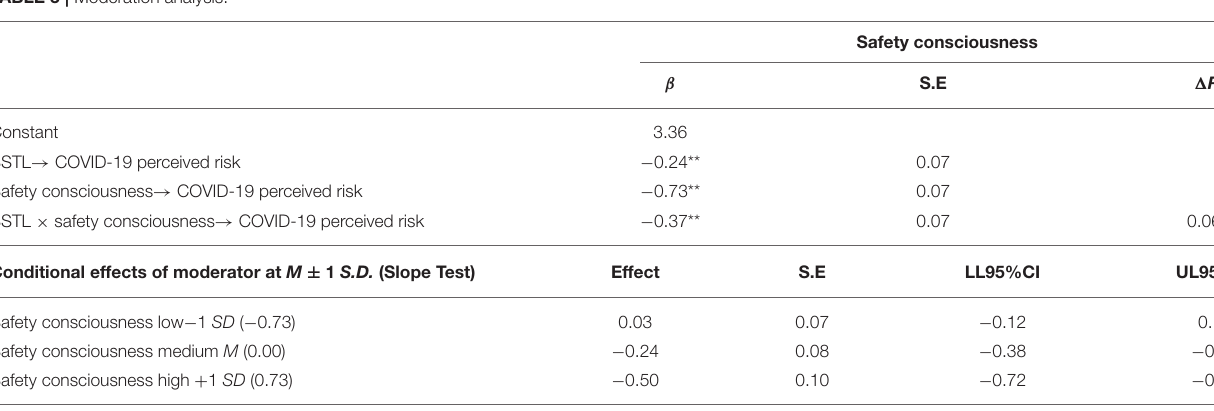
TABLE 3 | Moderation